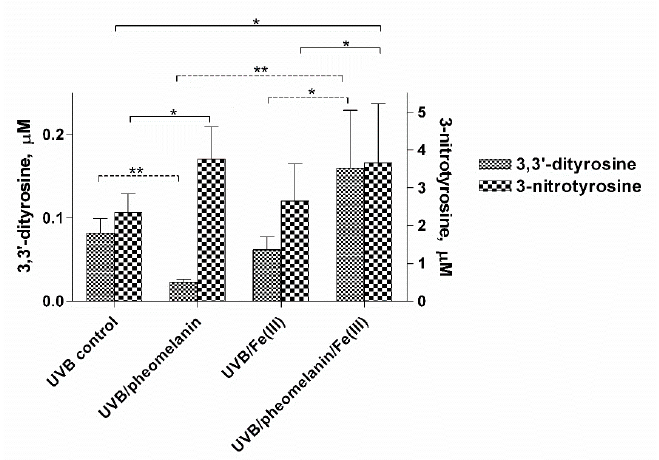
Figure 6 . Photooxidation of tyrosine by the nitrite/pheomelanin/UVB system: effect of Fe(III). Pheomelanin 4.2 μ g/mL is added to the reaction mixture containing 1 mM tyrosine, 10 mM K-nitrite, 0.1 mM DTPA in 0.2 M K-phosphate buffer at pH 5.5. The UVB control is pheomelanin free. Fe (III) is added as FeCl 3 at a concentration of 0.1 mM. The solution is exposed to UVB rays for 30 min. The reaction is stopped by placing the mixture in the dark and the supernatant, obtained after centrifugation, is analyzed by HPLC to determine the formation of 3-nitrotyrosine and 3,3 ′ - dityrosine, as reported in Materials and Methods. ** p < 0.01, * p < 0.05 .